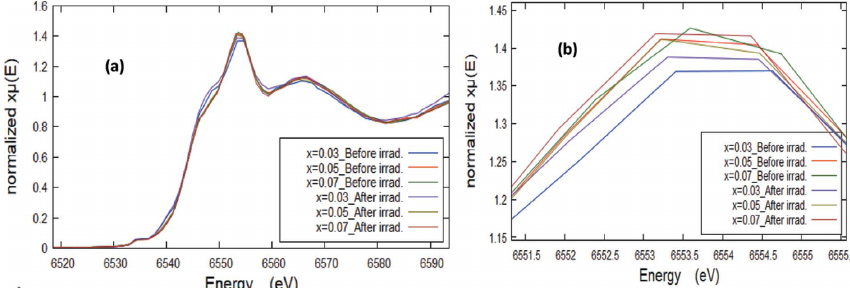
Figure 6 Normalized XANES spectra of samples before and after irradiation without y -offset for comparing the main absorption edge intensity at the Mn K